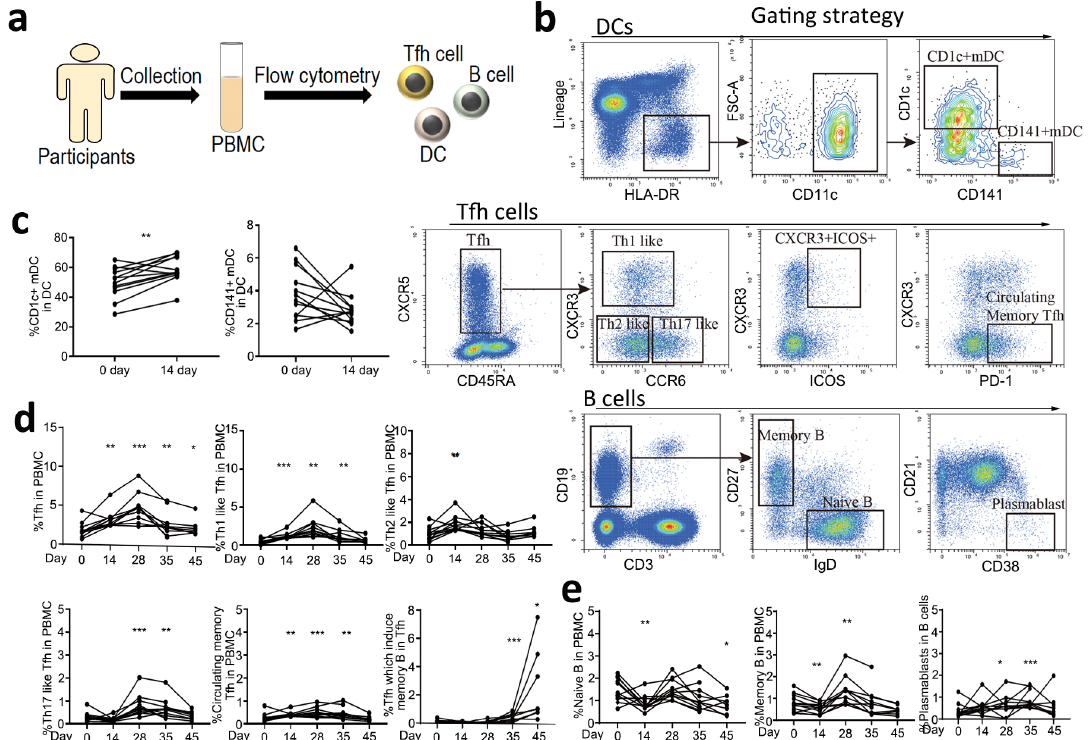
Figure 2. Specific immune response patterns of SARS-CoV-2 vaccine. ( a ) Flowchart of the cellular immune patterns assay. PBMCs were collected from 13 healthy participants, and DCs, Tfh cells, and B cells were analyzed by flow cytometry. ( b ) Gating strategies of flow cytometry. ( c ) The response of DCs before and after the first vaccination at Day 0 and 14. Day 0 (before vaccination) was as the control. Two tailed paired t test was used. ( d ) The response of Tfh cells, including Tfh cells, Th1-like Tfh cells, Th2-like Tfh cells, Th17-like Tfh cells, circulating memory Tfh cells, and Tfh cells, which induce memory B cells before and after ConoraVac vaccination at Day 0, 14, 28, 35, and 45. ( e ) The response of B cells, including naïve B cells, memory B cells, and plasmablasts before and after ConoraVac vaccination at Day 0, 14, 28, 35, and 45. For panels d and e, one-way RM ANOVA and Tukey’s multiple comparisons test were performed. Significance were annotated with Day 0